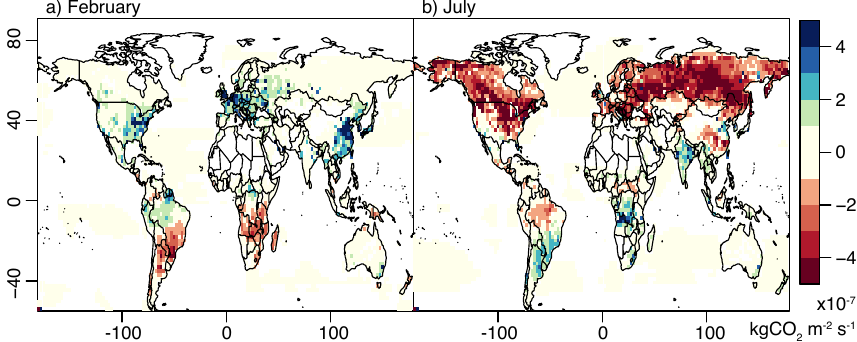
Figure 1. Average CarbonTracker CO 2 fluxes (version 2011oi) for (a) February and (b) July 2009. The fluxes include biosphere, ocean, fossil fuel, and biomass burning fluxes (http://www.esrl.noaa.gov/gmd/ccgg/carbontracker/CT2011_oi).